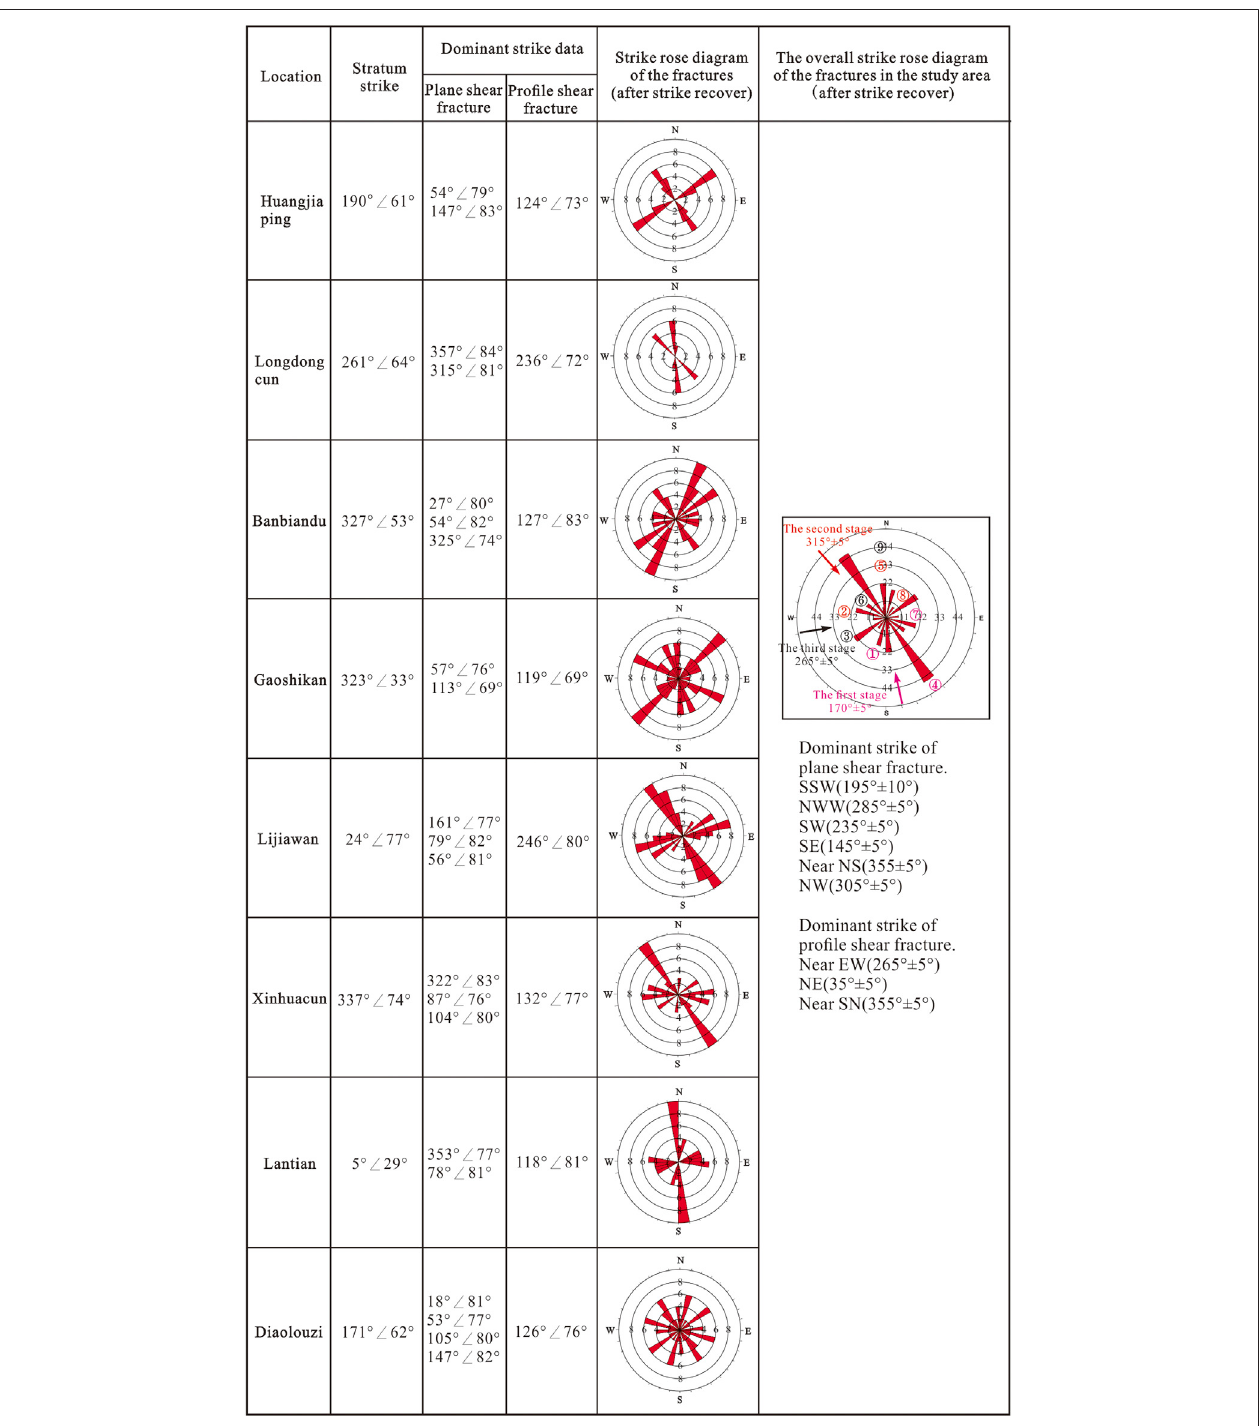
FIGURE 4 | Staging and supporting outcrop fractures in the Longmaxi Formation in the Yanjin – Junlian area.